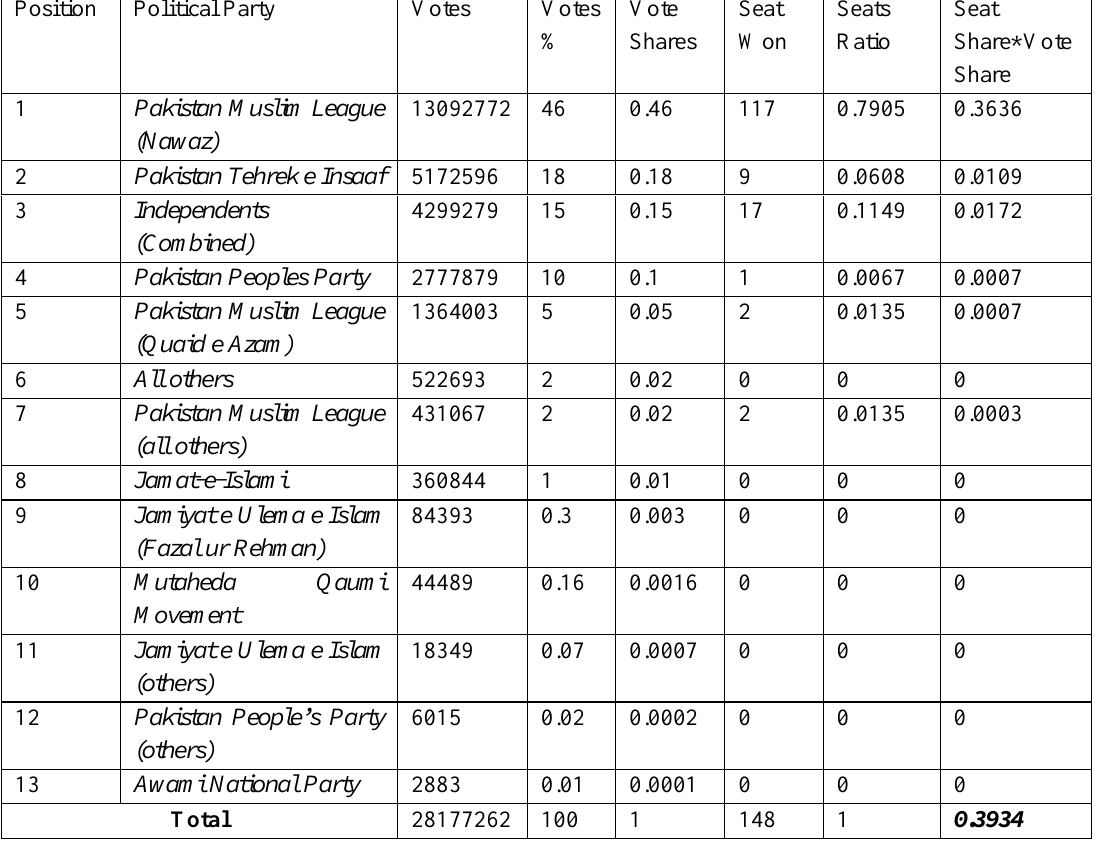
Table C1: Distribution of Seats and Votes in the Province of Punjab after the General Elections, 2013 Position Political Party Votes Votes